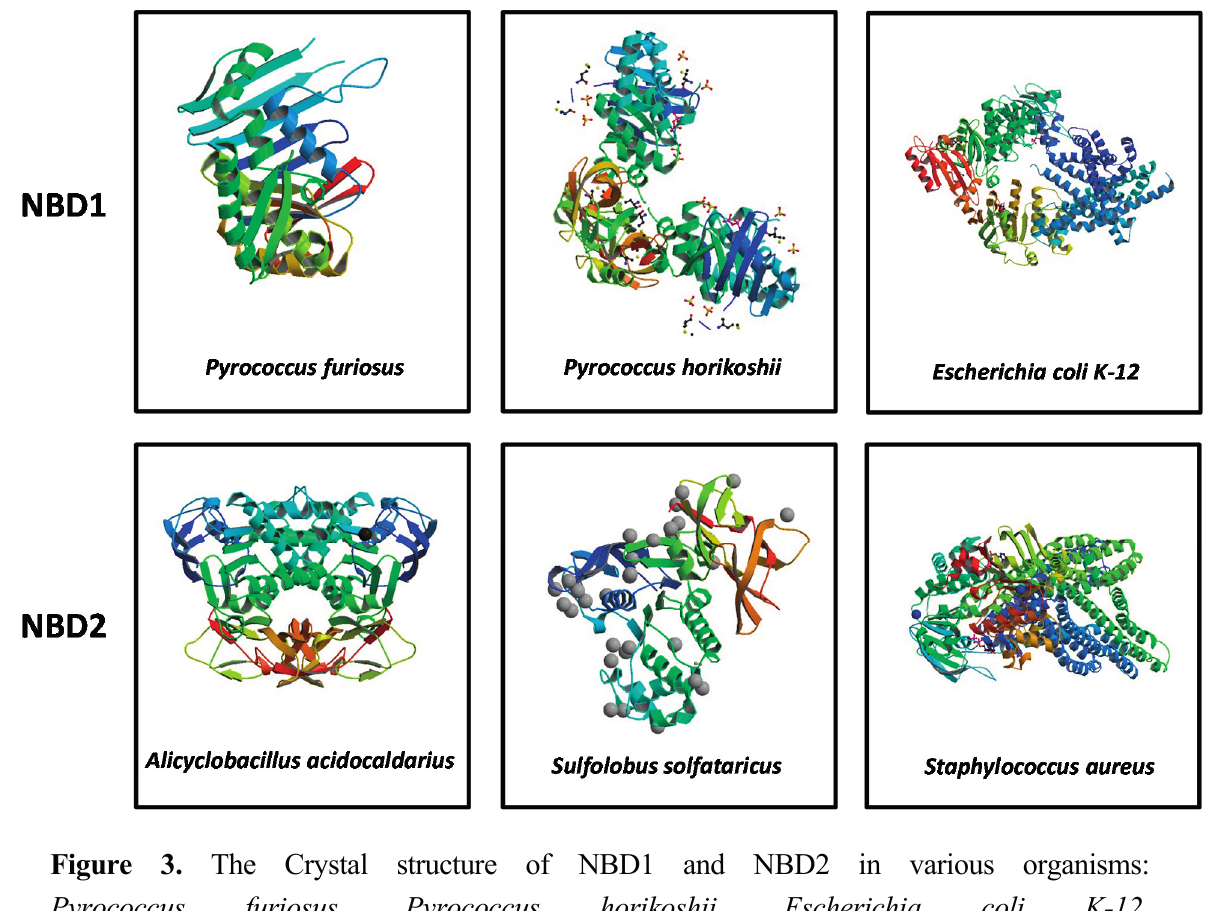
Figure 3. The Crystal structure of NBD1 and NBD2 in various organisms: Pyrococcus furiosus , Pyrococcus coli K-12 , Alicyclobacillus acidocaldarius , Sulfolobus solfataricus , and Staphylococcus aureus